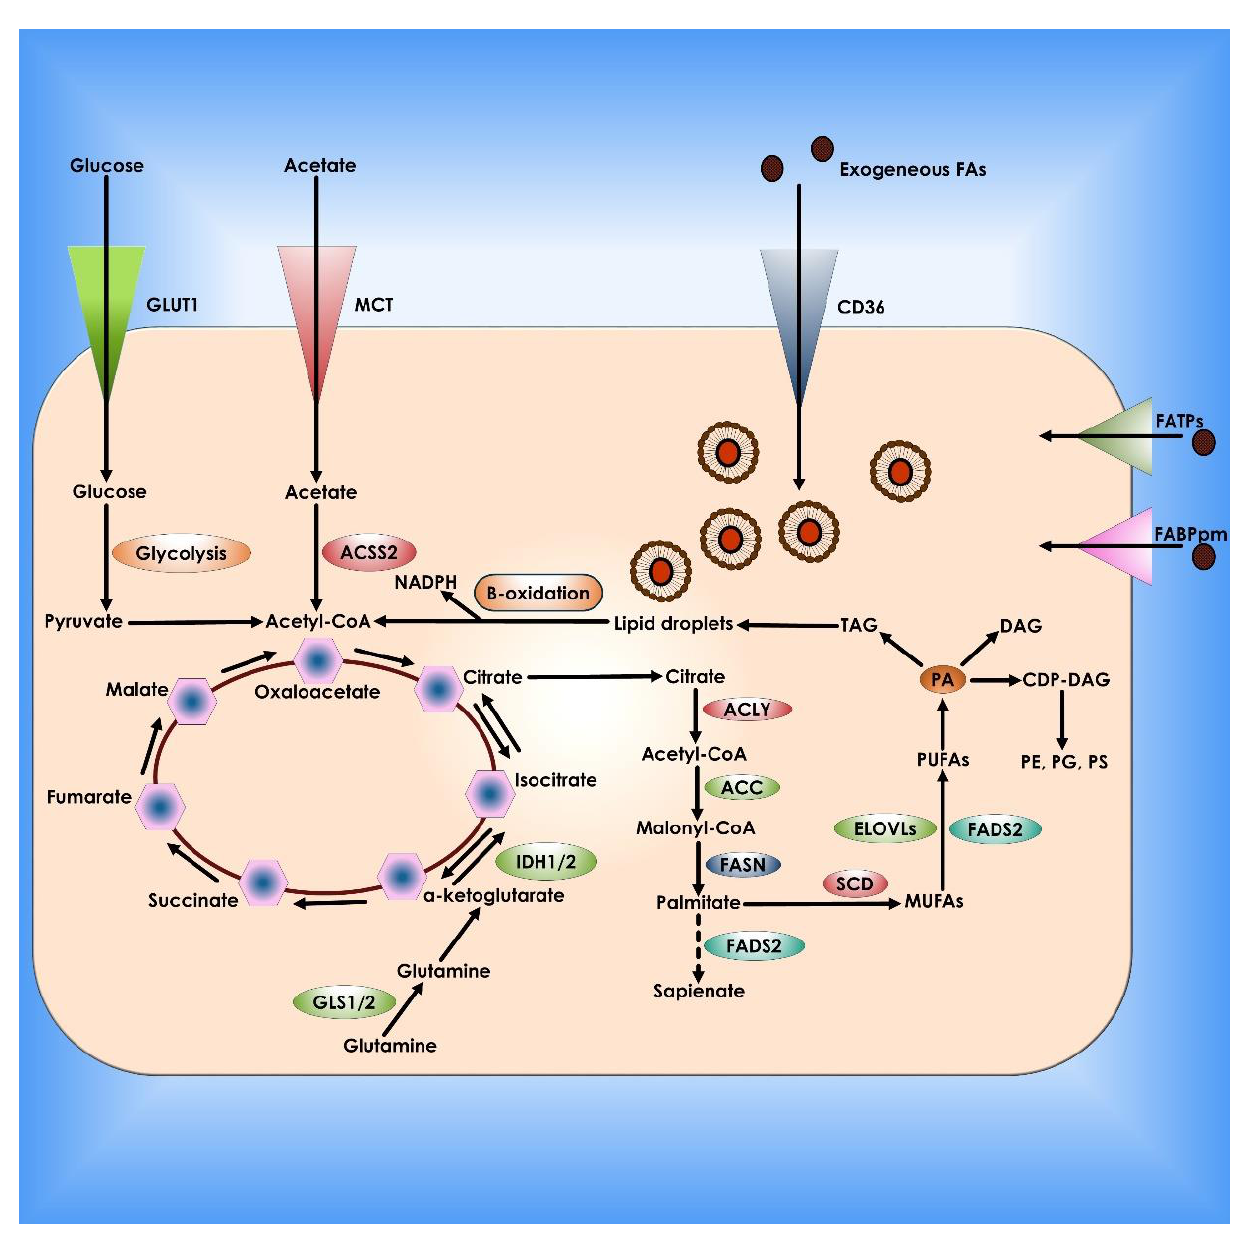
Figure 7. Lipid metabolism in Cancer Cells. De novo lipogenesis and exogenous absorption provide fatty acids (FAs) to cancer cells. Specialized transporters, including CD36, FATPs, and FABPpm, allow external absorption of FAs from the surrounding milieu. FAs and their synthetic products can then be stored as LDs and utilized to produce NADPH and acetyl-CoA via oxidation. Cancer cells use glucose, glutamine, and acetate to synthesize citrate as carbon sources for de novo lipogenesis. Palmitate is formed from citrate by the enzymatic activities of ACLY, ACC, and FASN and can then be desaturated and extended to create a broad set of lipid species. There is an alternate mechanism for palmitate desaturation that produces sapienate rather than palmitoleate via FADS2.